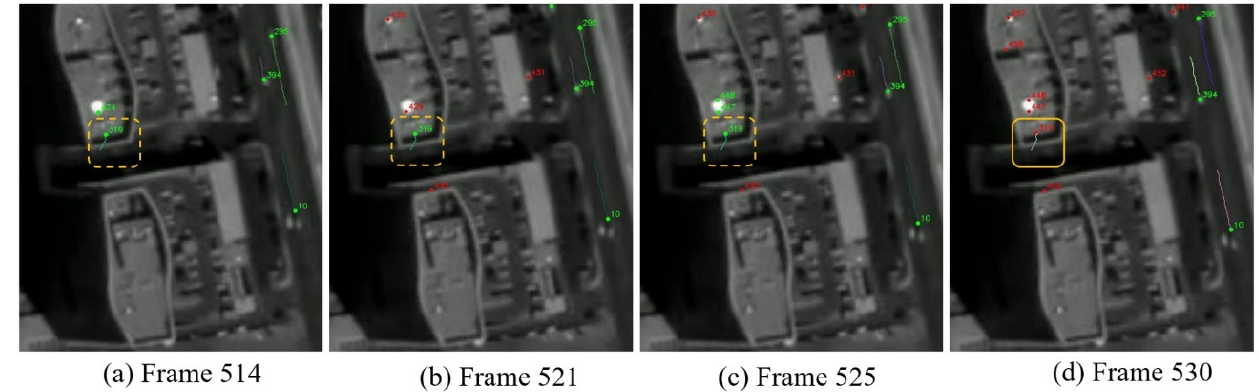
Figure 10. An example of a long tracklet of a false target from the top of a building.